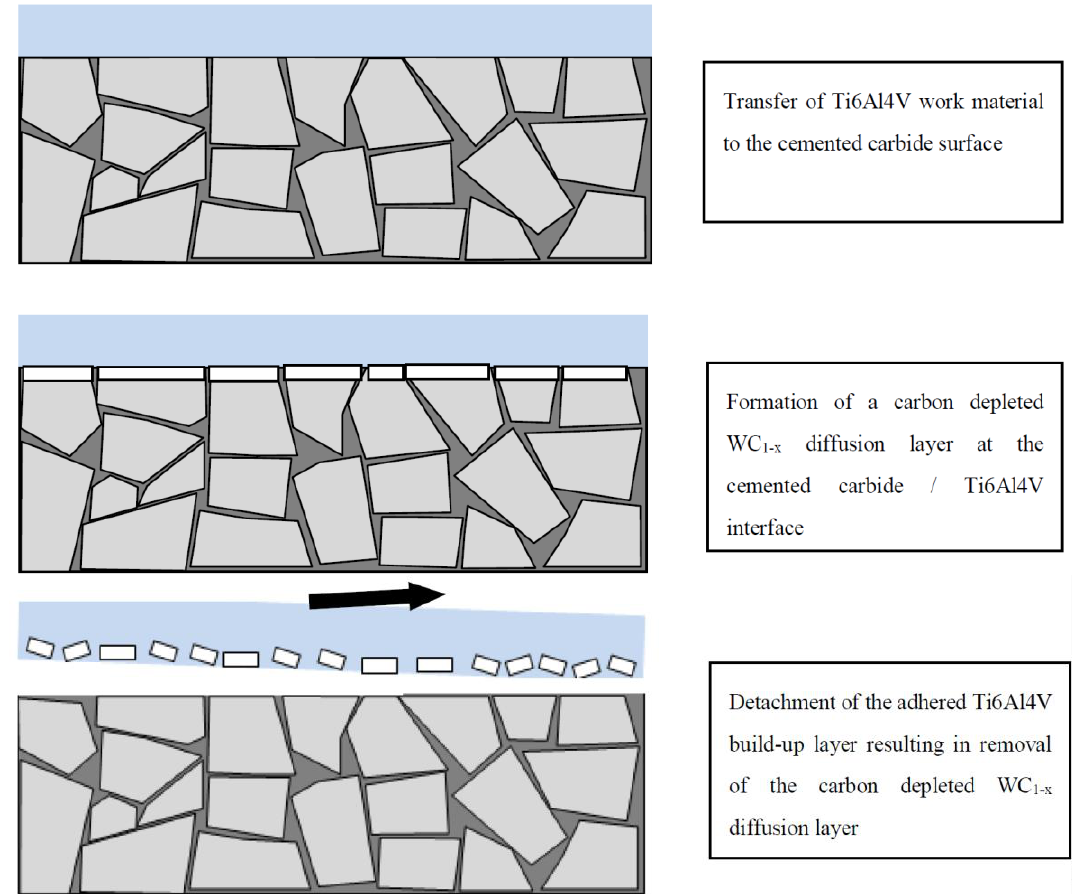
Figure 22. Schematic illustrating the degradation and wear of cemented carbide during turning of Ti6Al4V. The lower strength of the WC 1 − x diffusion layer at the cemented carbide/Ti6Al4V interface will promote detachment of the adhered build-up layer, including part of the WC 1 − x diffusion layer.